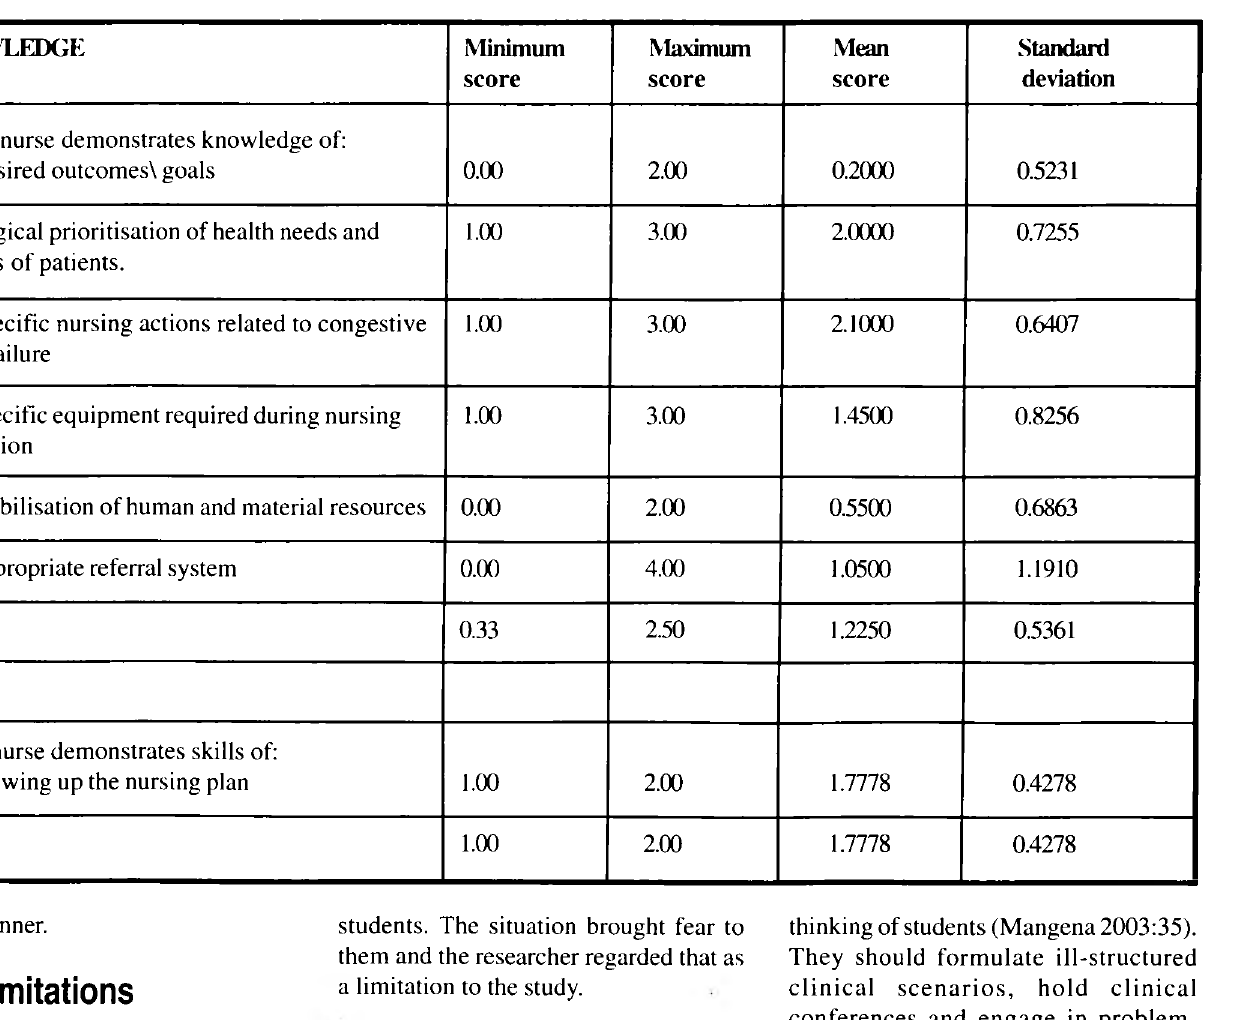
Table 1.4: Scores obtained by participants on planning 1.